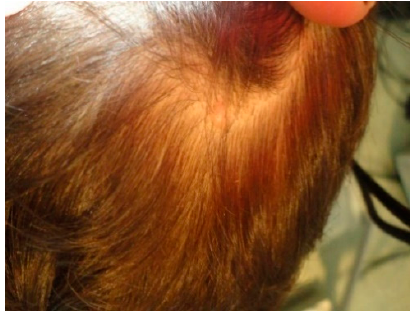
Figure 6. Scalp cylindroma.